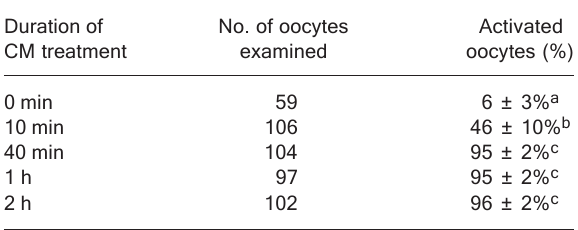
Table 1. Effect of mesenchymal stem cell conditioned medium (CM) on the activation of mouse oocytes.